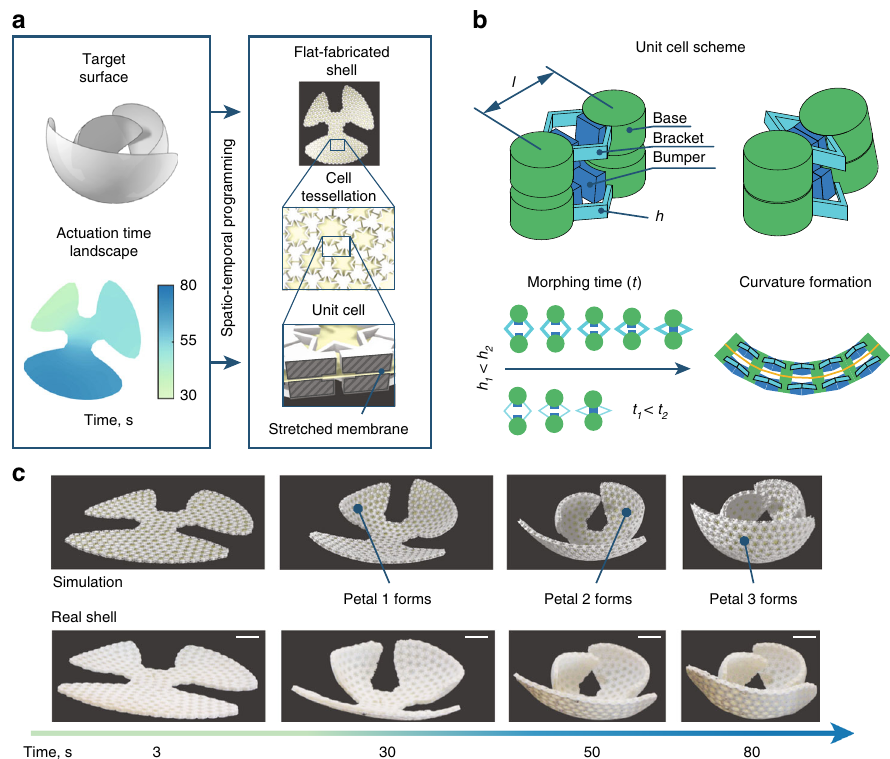
Fig. 1 Encoding spatial and temporal shape evolution in a fl at shell mesostructure. a A user-speci fi ed target surface and actuation time landscape (a fi eld of deformation completion times) are inputs to an inverse design procedure that de fi nes the mesostructure of fl at-fabricated shells that morph into the target geometries. The shells are composed of inhomogeneous tessellations of unit cells with an interior pre-stretched membrane. b Each unit cell has an initial central length l . Brackets control actuation time through their softening rate, which is controlled by their thickness, h , and a set of bumpers prescribe fi nal local curvatures upon collision. c Morphing of a petalled structure with an actuation time landscape ensuring that larger petals cover their smaller neighbors avoiding collisions on the way. Simulation and experiments are compared at 3, 30, 50, and 80 seconds in water. The structure replicates the encoded actuation time landscape shown in ( a ). Scale bars, 3